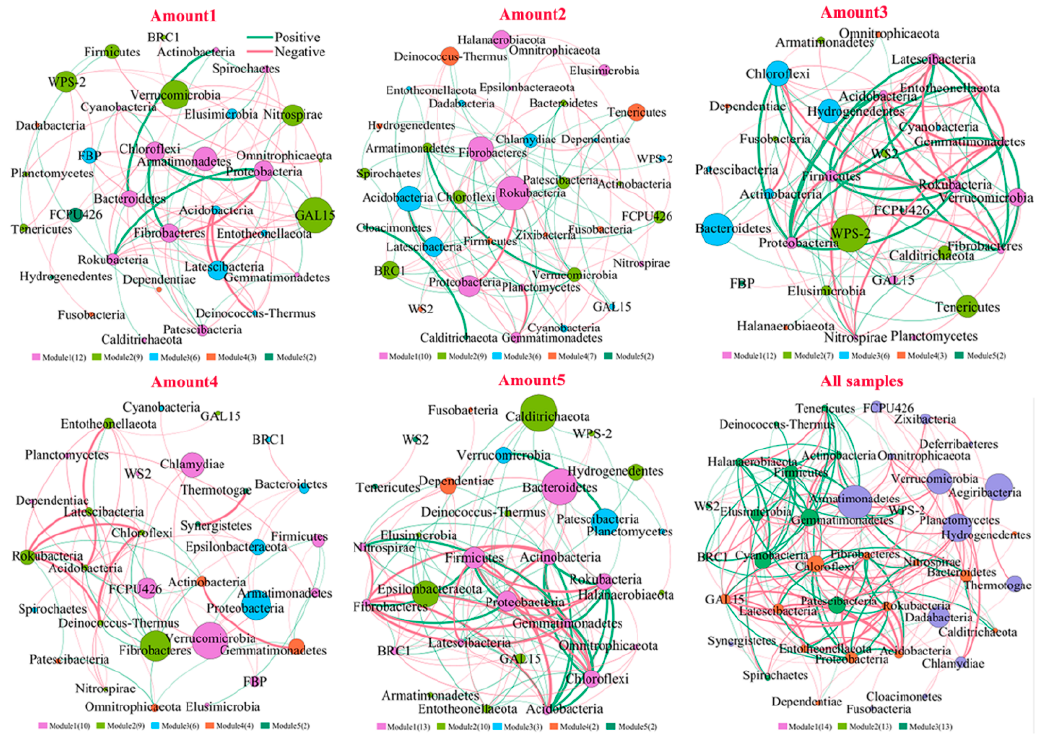
Figure 7. Co-occurrence networks of bacteria in sediments with different TiO 2 NP addition amounts. Green and red lines represent significantly positive and negative correlations, respectively.